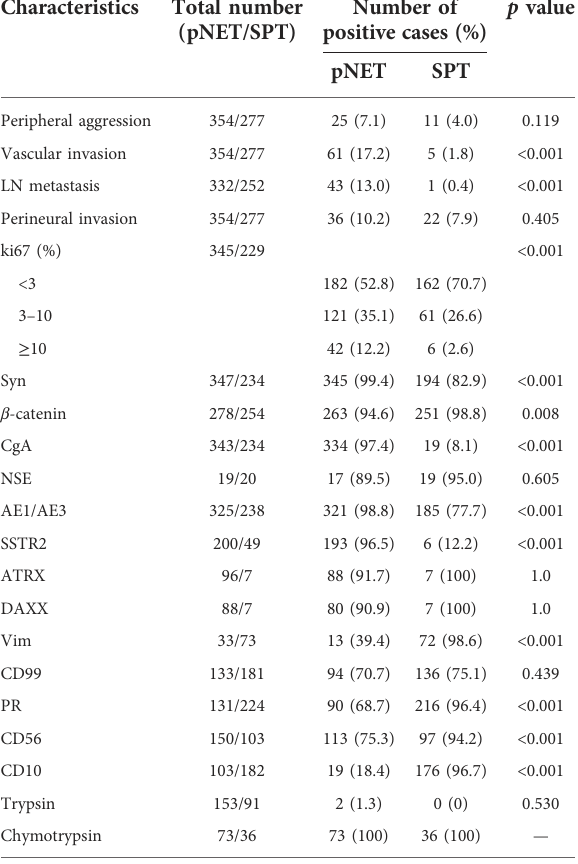
TABLE 5 Pathological pro fi les of pNET and SPT. TABLE 6 Multivariate analysis of demographic and radiological